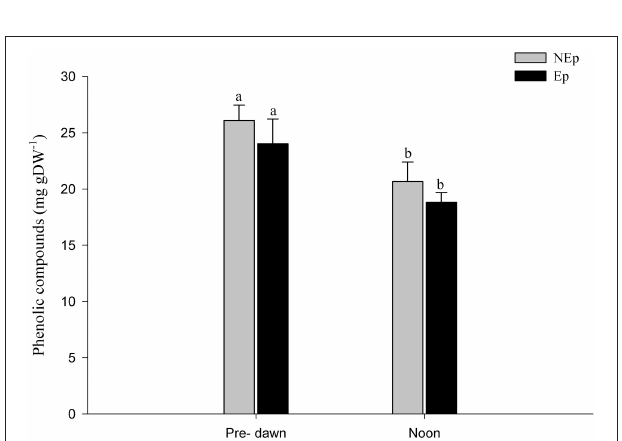
FIGURE 6 | Phenolic compounds concentration in Posidonia oceanica leaves with (Ep) and without (NEp) epiphytes, at pre-dawn and noon. Different letters indicate significant differences between pre-dawn and